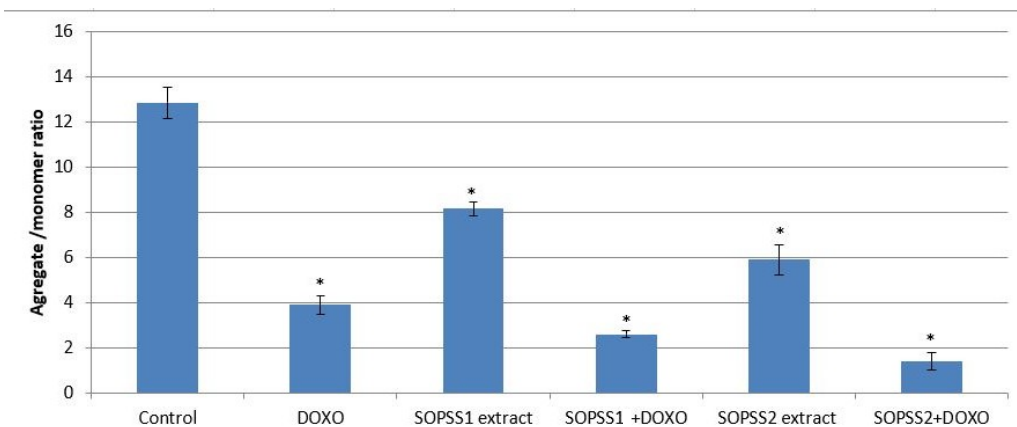
Figure 9. Mitochondrial membrane potential upon exposure to transgenic SOPSS1 and SOPSS2 root extracts (alone or with combination with IC 50 doxorubicin) for 24 h on NALM6 cells. Results are shown as mean ± SD (n = 3),* p < 0.05 control vs. transgenic SOPSS1 and SOPSS2 hairy root extracts (alone or combination with doxorubicin). Doxorubicin-treated cells are used as a positive control.